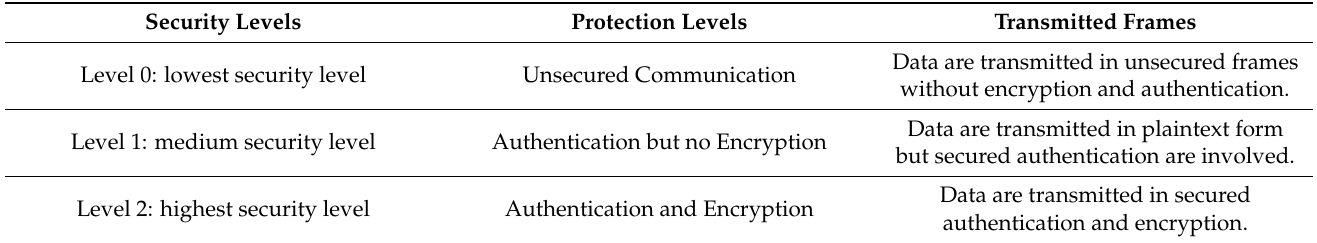
Table 11. Three security levels in the IEEE 802.15.6 standard for WBANs.